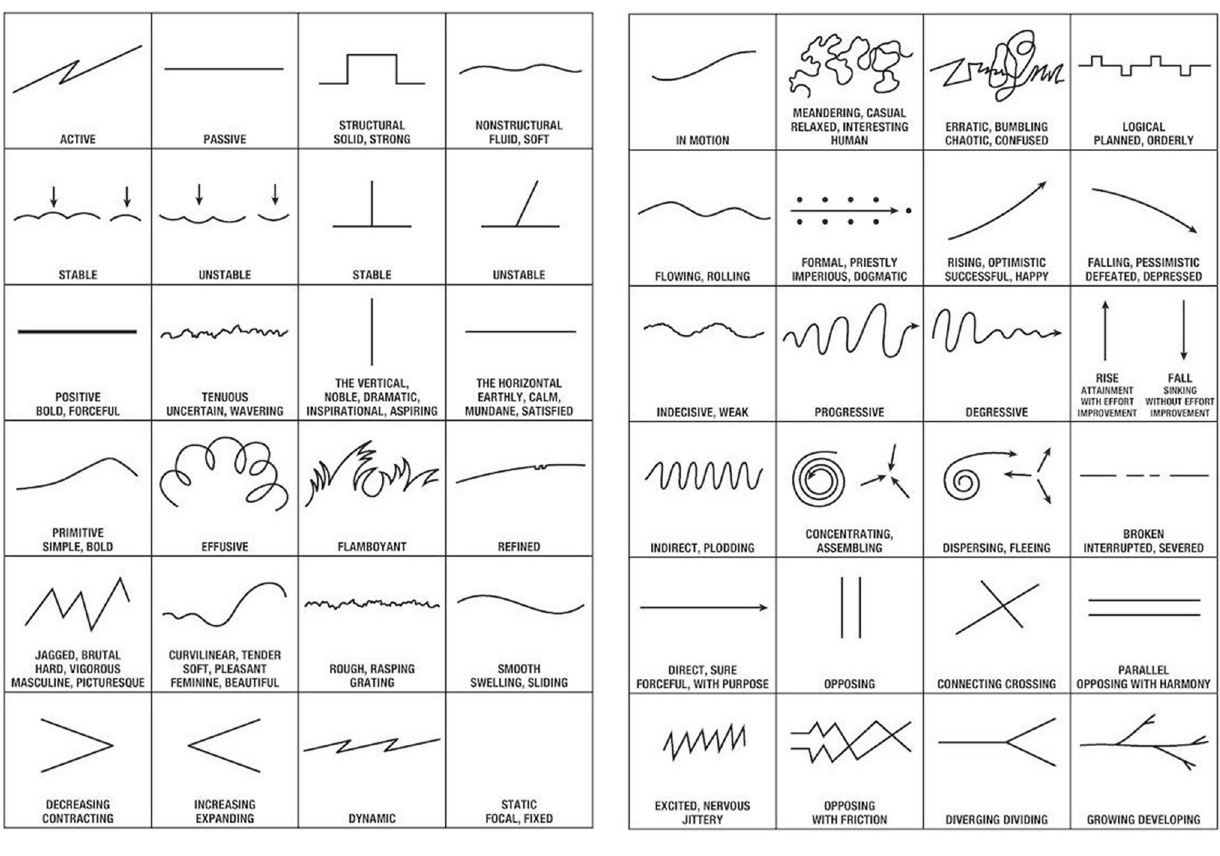
Stability, trust, honesty, order, conformity, security, equality, masculinity, maturity, balance, stubbornness Action, aggression, energy, sneakiness, conflict, tension, masculinity,